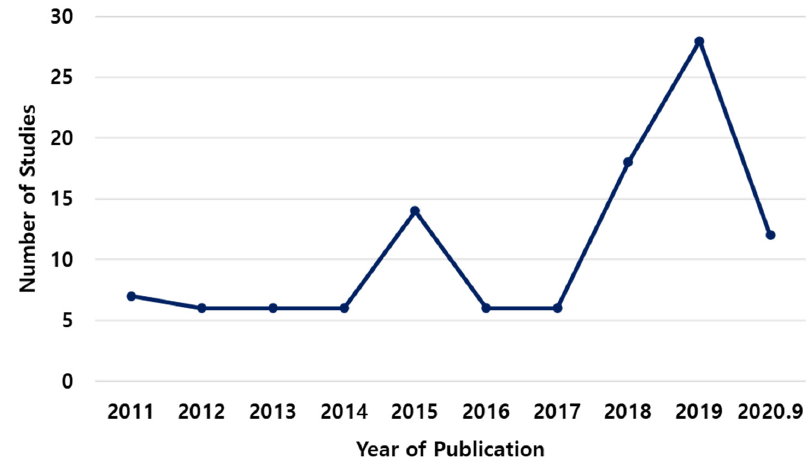
Figure 2. Publications per year (January 2011–September